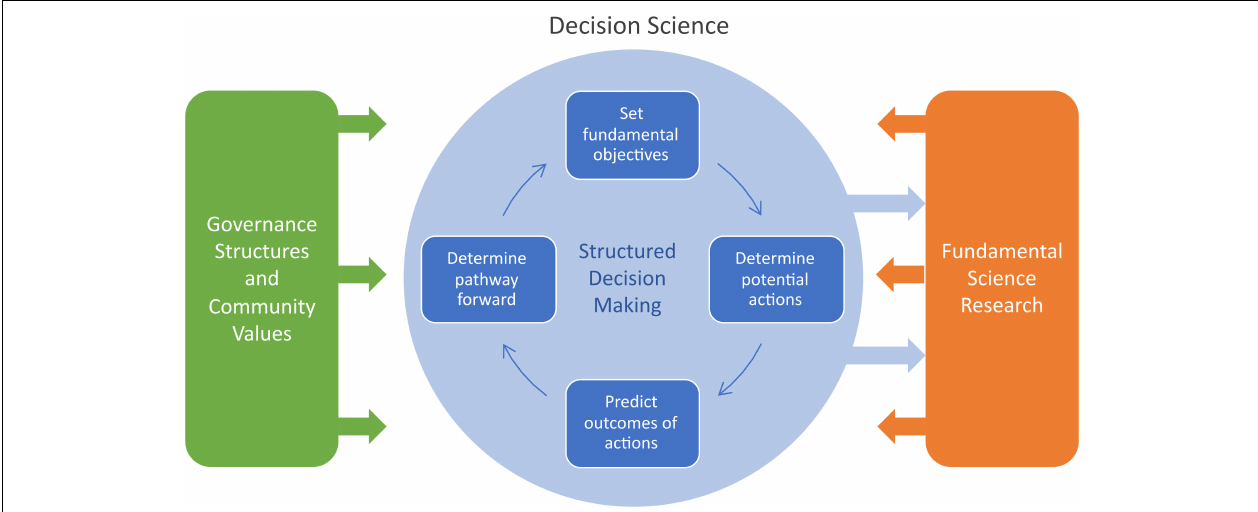
FIGURE 1 | Decision science framework. Our vision of decision science for impact embeds Structured Decision Making as the nexus between the social, political and organizational context in which decisions are made and implemented and the science underlying the problem. Fundamental knowledge is integrated within the decision-making process, while incorporating the overarching governance structures and community values. When approached in a cyclic manner, with objectives and models being revised and refined over time, it becomes “adaptive management” (Canessa et al., 2016). The process both informs and is informed by fundamental science